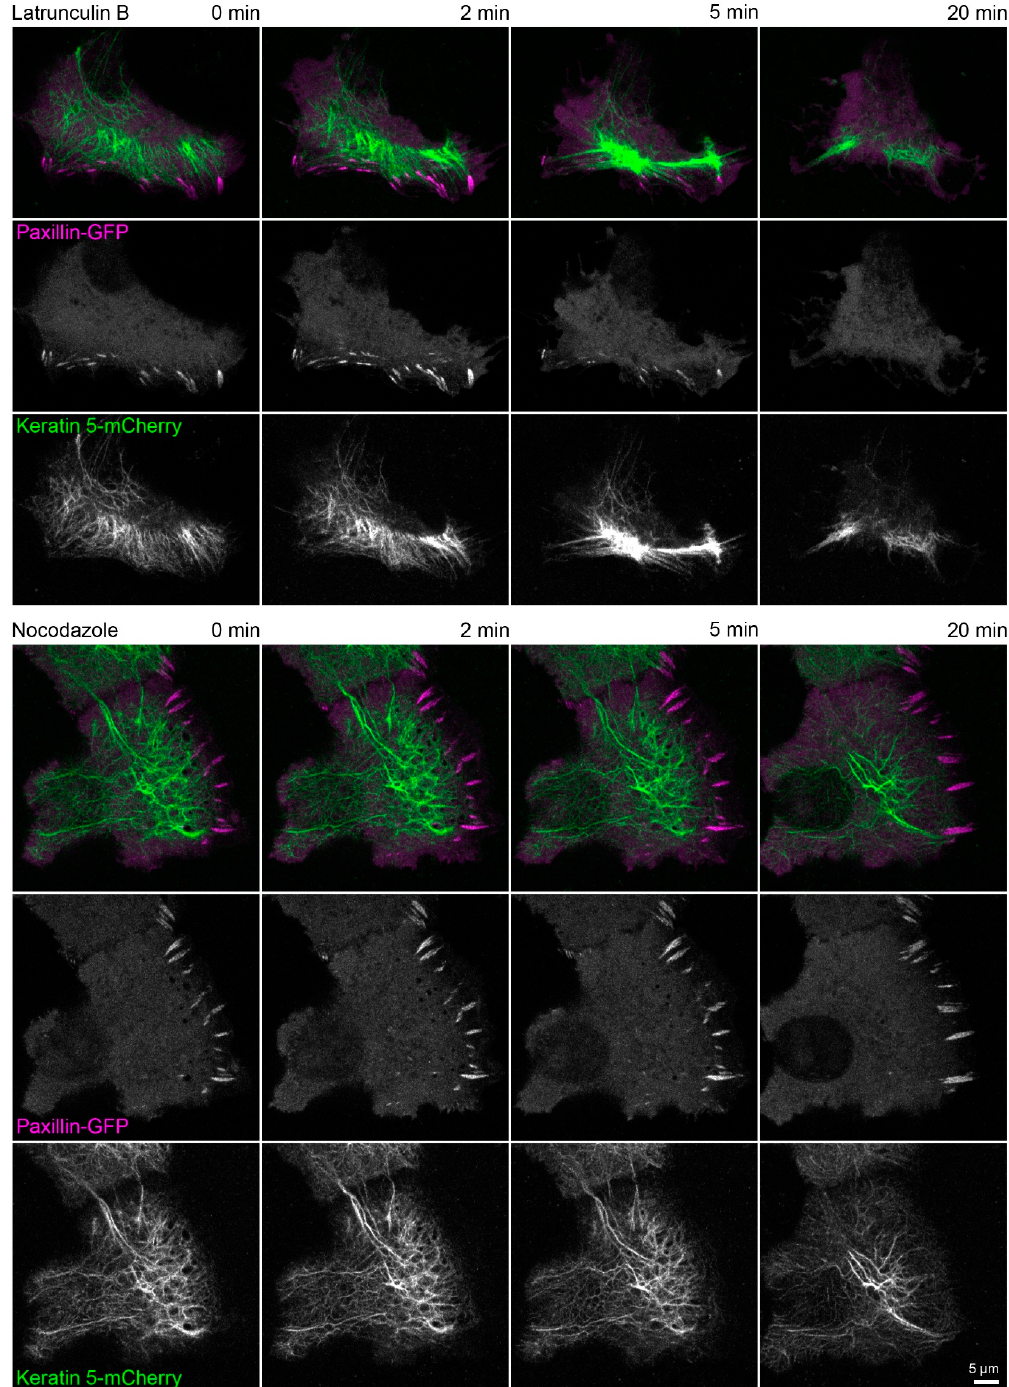
Figure A4. Actin polymerization is necessary for focal adhesion maintenance and assembly. The fluorescence images show the distribution of keratin 5-mCherry and paxillin-GFP in living HaCaT cells before and after treatment with 3 µM latrunculin B (upper part) or 20 µM nocodazole (lower part). Focal adhesions are disassembled within 20 min in the cell treated with latrunculin B and the keratin network strongly retracts but remains partially attached in cell periphery. On the other hand, focal adhesions in the cell treated with nocodazole persist and a delicate keratin network is still present after 20 min. All fluorescence images are maximum intensity projections of lower focal planes ( z = 0 to 1.05 µm; 4 planes) ( n = 4 and n = 3). The regions where focal adhesions are mainly located correspond to the cell colony edge. Both time-lapse series are shown in Video